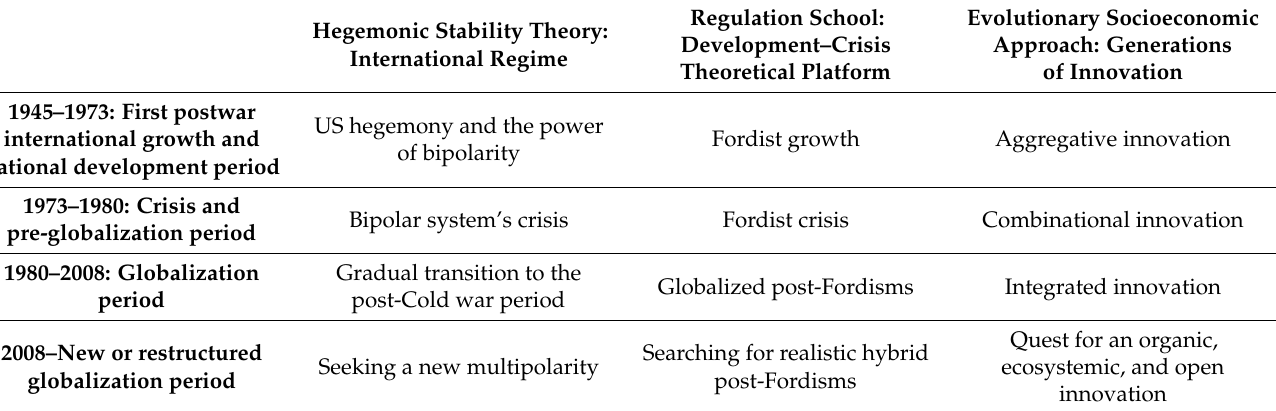
Table 1. The emerging new globalization is the recent phase in the global system’s evolutionary